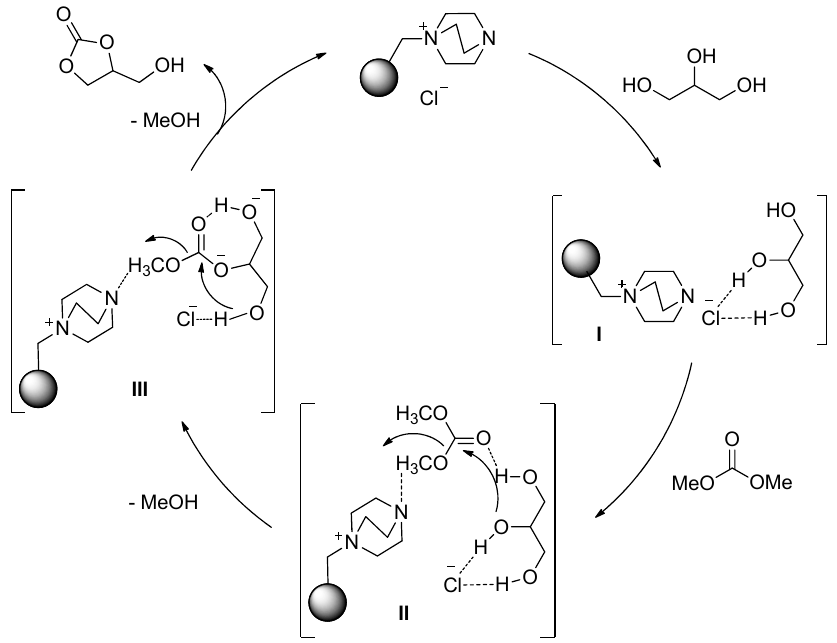
Figure 11. Plausible mechanism of DABCO-anchored Merrifield resin-catalyzed transesterification of glycerol, (reprinted with permission from Reference [116], Elsevier, 2015).